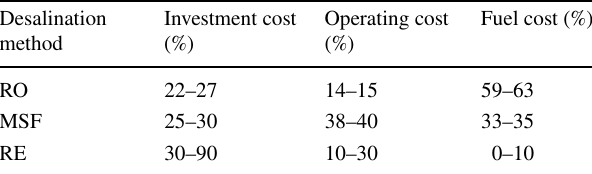
Table 6 Production capacity and construction cost of some desalina- tion plants (Mentis et al. 2016) Desalination method